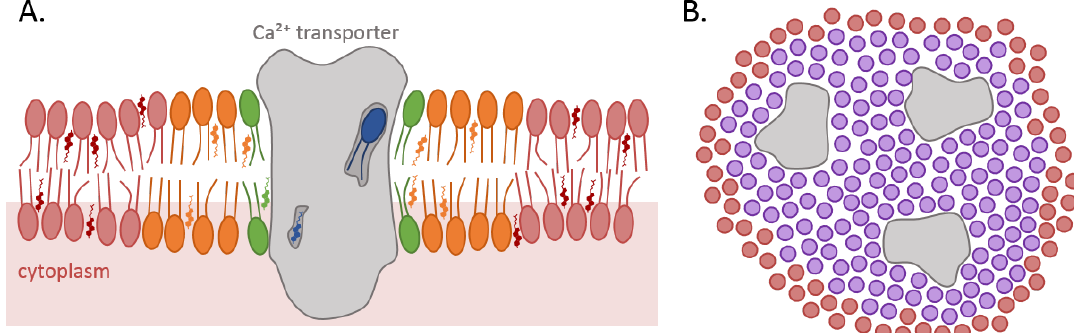
Figure 1. Simplified representation of potential modes of interactions between lipids and Ca 2+ transport proteins. ( A ) Side view of a single protein anchored in the membrane. First, non-annular lipids (blue) interact directly with the protein (grey) inside its structure. Second, annular lipids from the first shell (green) can closely interact with the protein. Third, the annulus of surrounding lipids (orange) can also modulate protein activity through its biophysical properties. ( B ) Top view of several proteins gathered in one lipid domain (purple), as a fourth potential mode of interaction. Bulk lipids are represented in red.